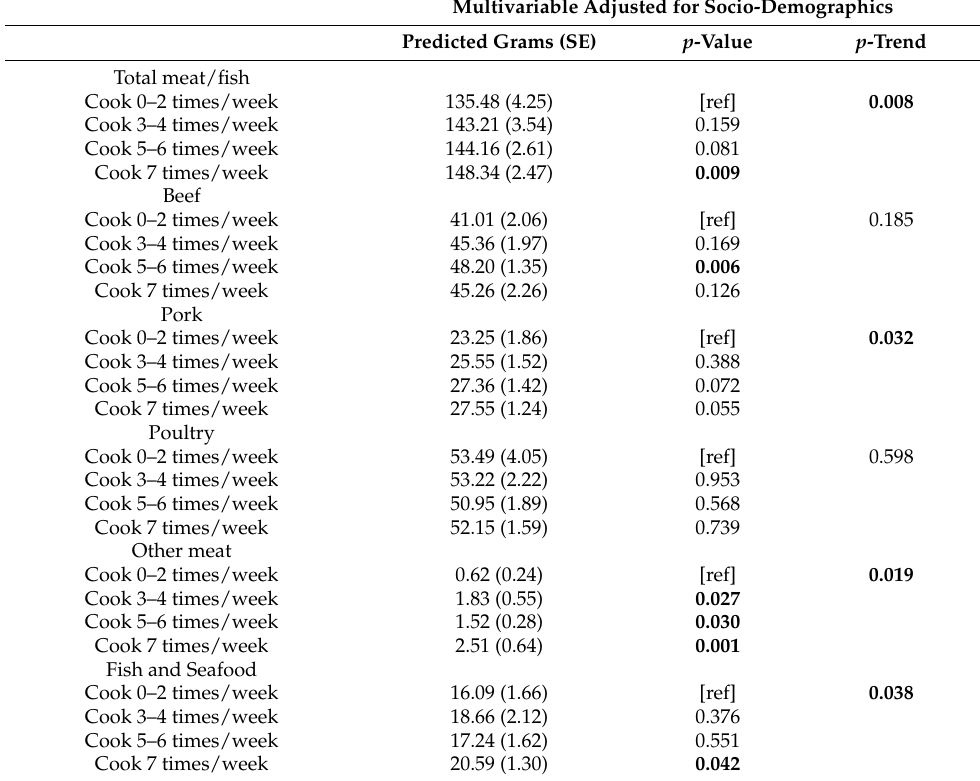
Table A3. Meat, Fish, and Dairy Consumption (Grams Per 2000 kcal) by Cooking Frequency, NHANES